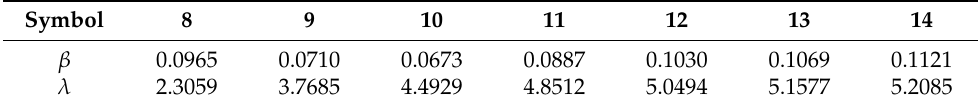
Table 3. Mean and standard deviation between 8 and 14 h.